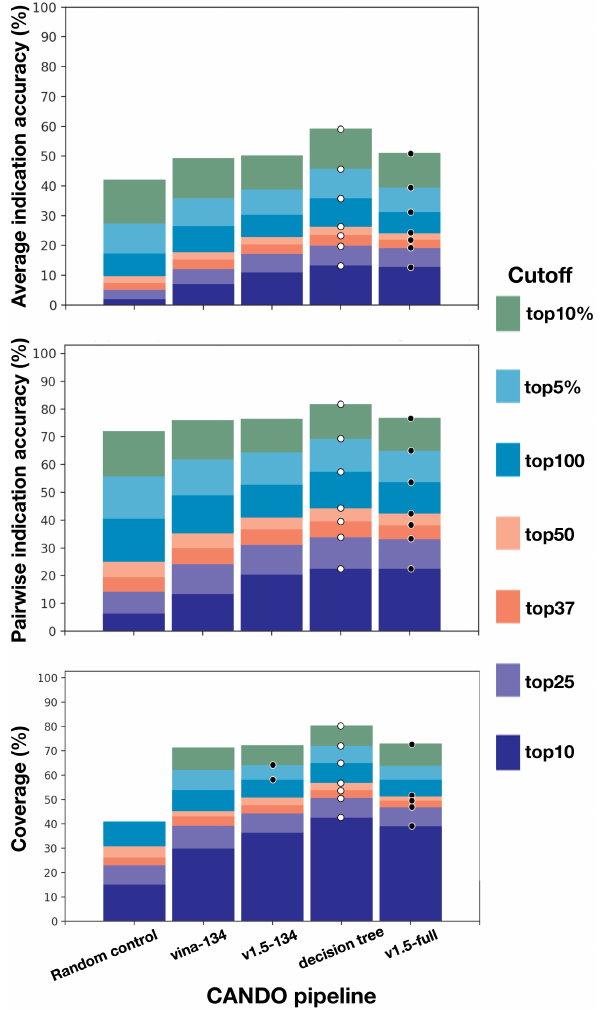
Figure 2. Benchmarking performance of CANDO pipelines used in this study. Three docking-derived pipelines implemented in CANDO: v1.5-full, using the interaction scores generated by the default CANDO v1.5 bioanalytical or similarity docking protocol (BANDOCK) for the full (46,784) proteome library, v1.5-134, using the same interaction scoring protocol for a 134 protein sublibrary, and Vina-134, based on interaction scores generated using AutoDock Vina for the 134 protein sublibrary are com- pared with a hybrid decision tree pipeline derived from combining the individual pipelines, as well as the random control reference pipeline calculated numerically from a hypergeometric distribution [43]. The pipelines were assessed by three CANDO platform benchmarking metrics: average indication accuracy (%), pairwise accuracy (%), and coverage (%). Performance cutoffs are denoted by colored bars from most to least stringent: top10 (dark purple), top25 (light purple), top37/top1% (dark pink), top50 (light)pink, top100 (dark blue), top5% (light blue), top10% (dark green), and top50% (light green) for 1439 indications with at least two approved drugs using a leave-one-out bench- marking protocol (see the Methods Section). White dots denote the highest overall accuracy at each threshold. The hybrid decision tree pipeline, which incorporates the highest indication accuracies from the Vina-134 and v1.5-134 pipelines, performed the best at all cutoffs (white dots). Black dots denote high performance in individual pipelines, which was obtained using the two v1.5 pipelines, one based on the 134 proteome sublibrary and the other on the full proteome library. v1.5-134 yielded the highest top50 percent average indication accuracy (85.3%), top100 coverage (52.742%), top5% coverage (64.382%), and top50% coverage (96.064%). Individually, the Vina-134 pipeline significantly outperformed the random control and yielded a significant fraction of the performance of the v1.5 pipelines. The hybrid decision tree pipeline performed the best, indicating that diversity in pipeline simulation implementation can be leveraged to increase drug repurposing